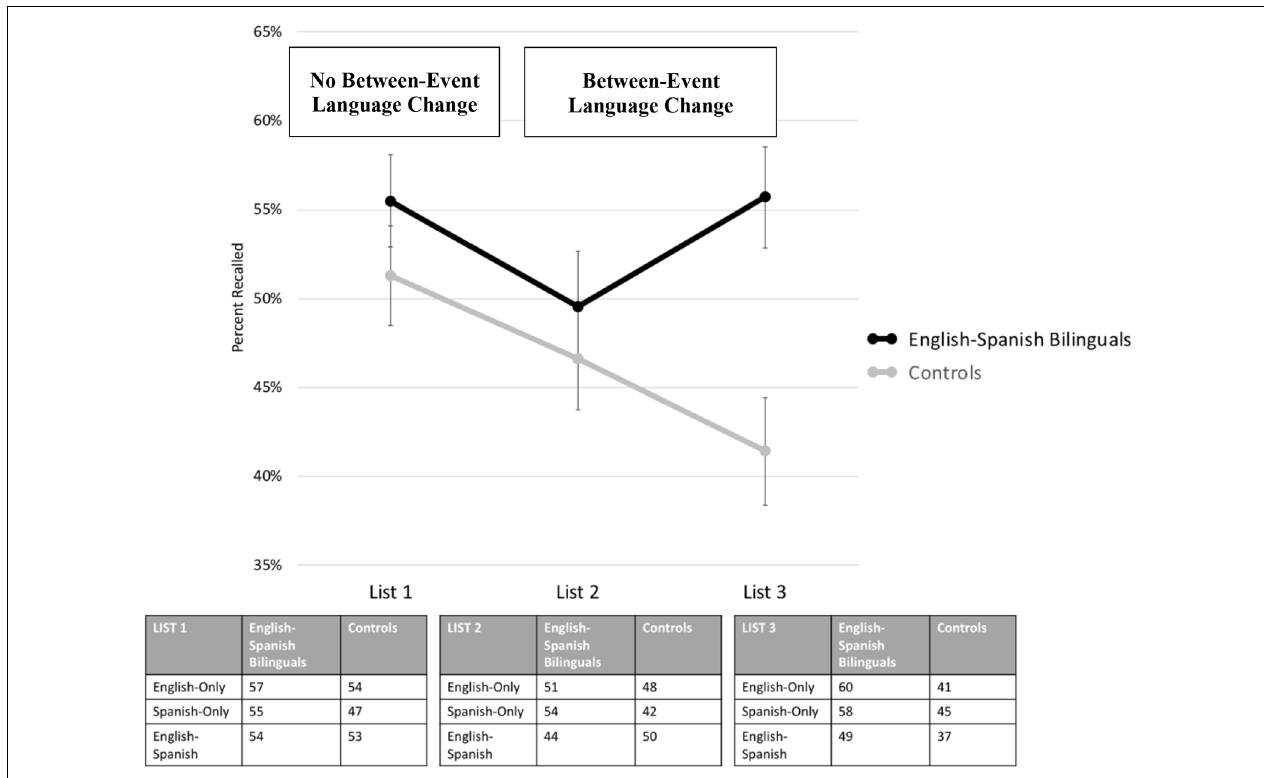
FIGURE 4 | Visual memory performance when there was (and was not) a change in language context between events. This image displays visual memory performance for English-Spanish Bilinguals (top line) and Controls (bottom line) when there was no between-event language context change (i.e., List 1) and when there was a between-event language context change (i.e., Lists 2 and 3). The mean percentage of shapes recalled for the three language contexts (English-Only, Spanish-Only, and English-Spanish) are displayed at the